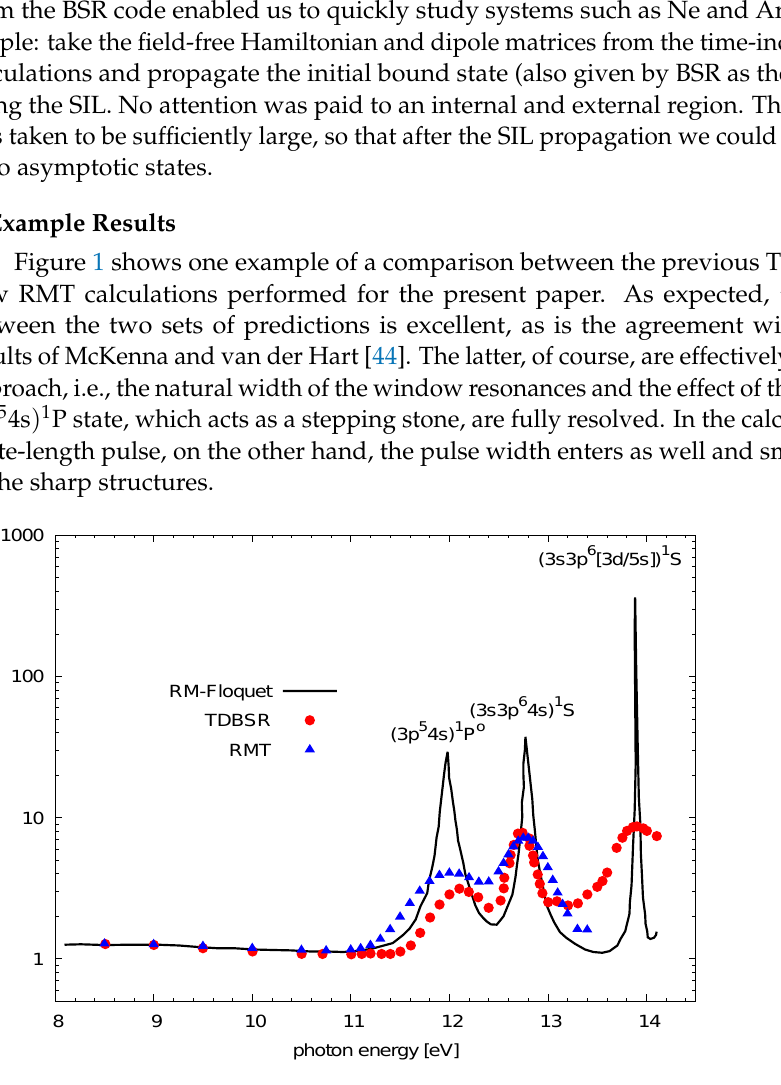
Figure 1. Generalized cross section for two-photon ionization of Ar ( 3p 6 ) 1 S as a function of photon energy. A 30-cycle laser pulse with a sine-squared field envelope and a peak intensity of 10 12 W/cm 2 was used in the calculations. The Floquet results of McKenna and van der Hart [44] are compared with those from the previous TDBSR [25] and the current RMT